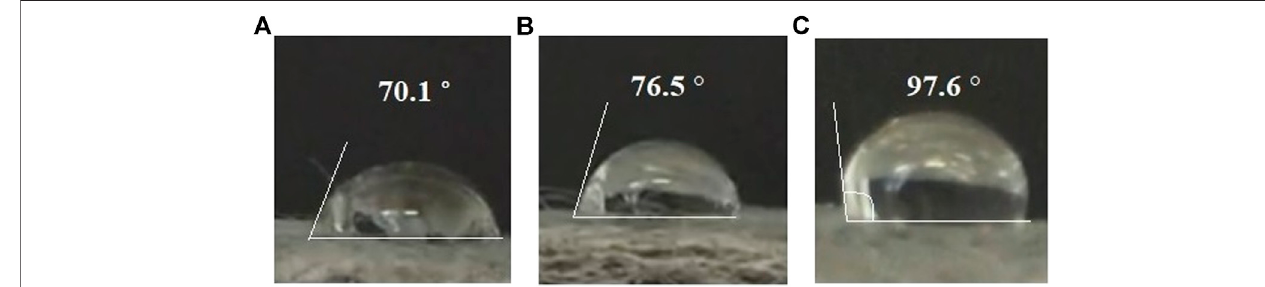
FIGURE 2 | Contact angle on the polypropylene.